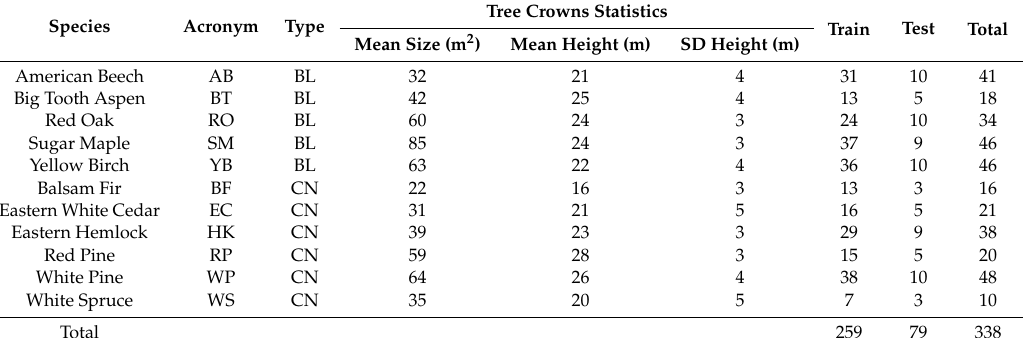
Figure 2. Manually delineated crowns by photo-interpretation and their corresponding GPS points collected during the field campaign. The background image displays WorldView-3 in false colors (infrared, green and blue). The species’ abbreviations are described in Table 2. Table 2. Distribution of the different tree species samples (train and test) and tree crowns statistics of each species. BL: Broadleaf, CF: Conifer.